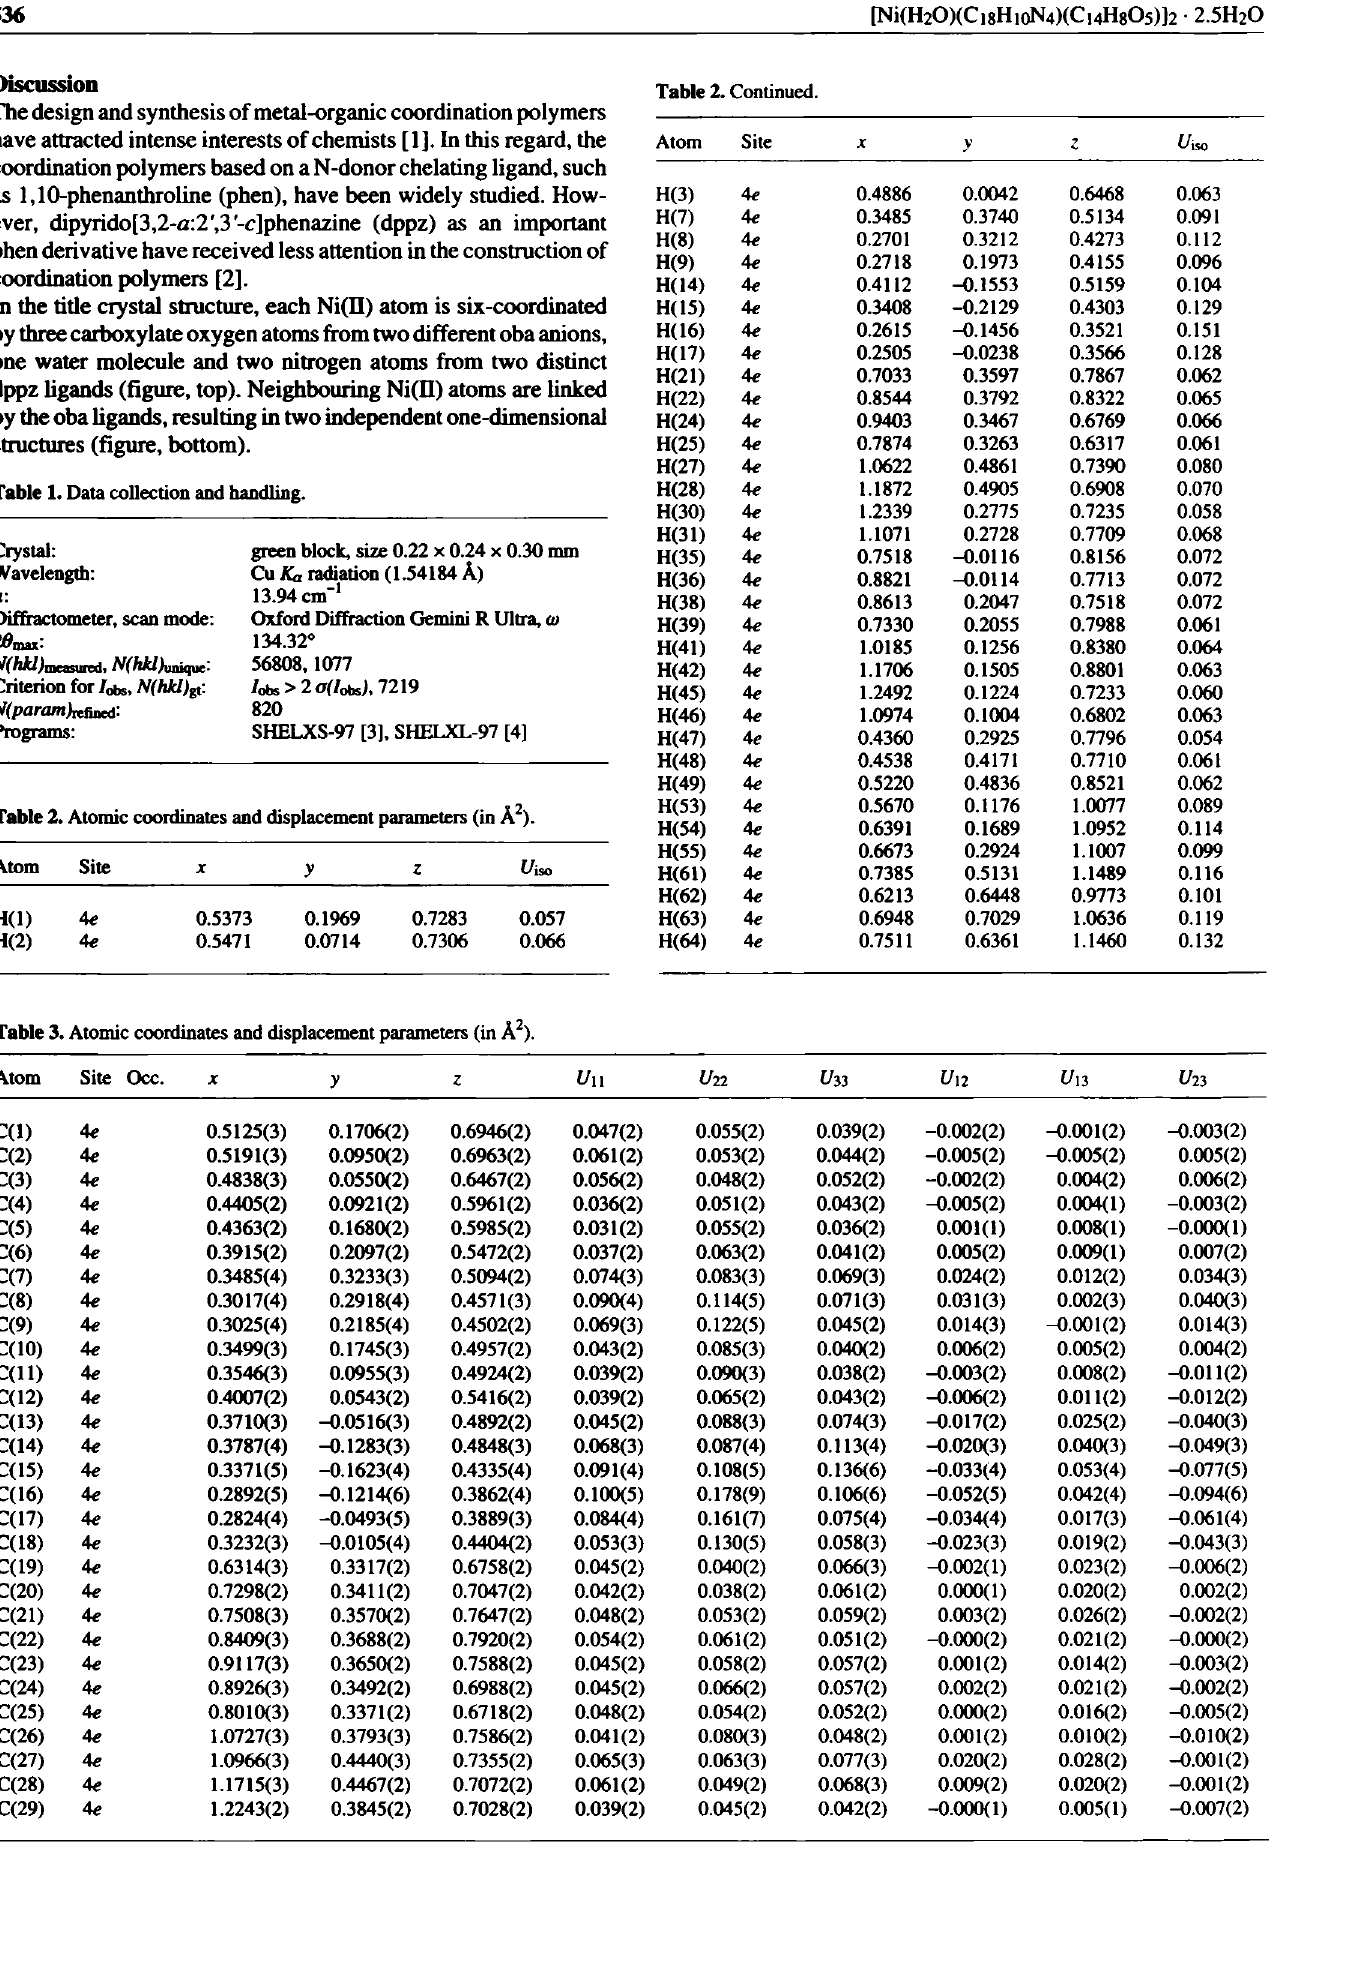
Table 3. Atomic coordinates and displacement parameters (in À 2